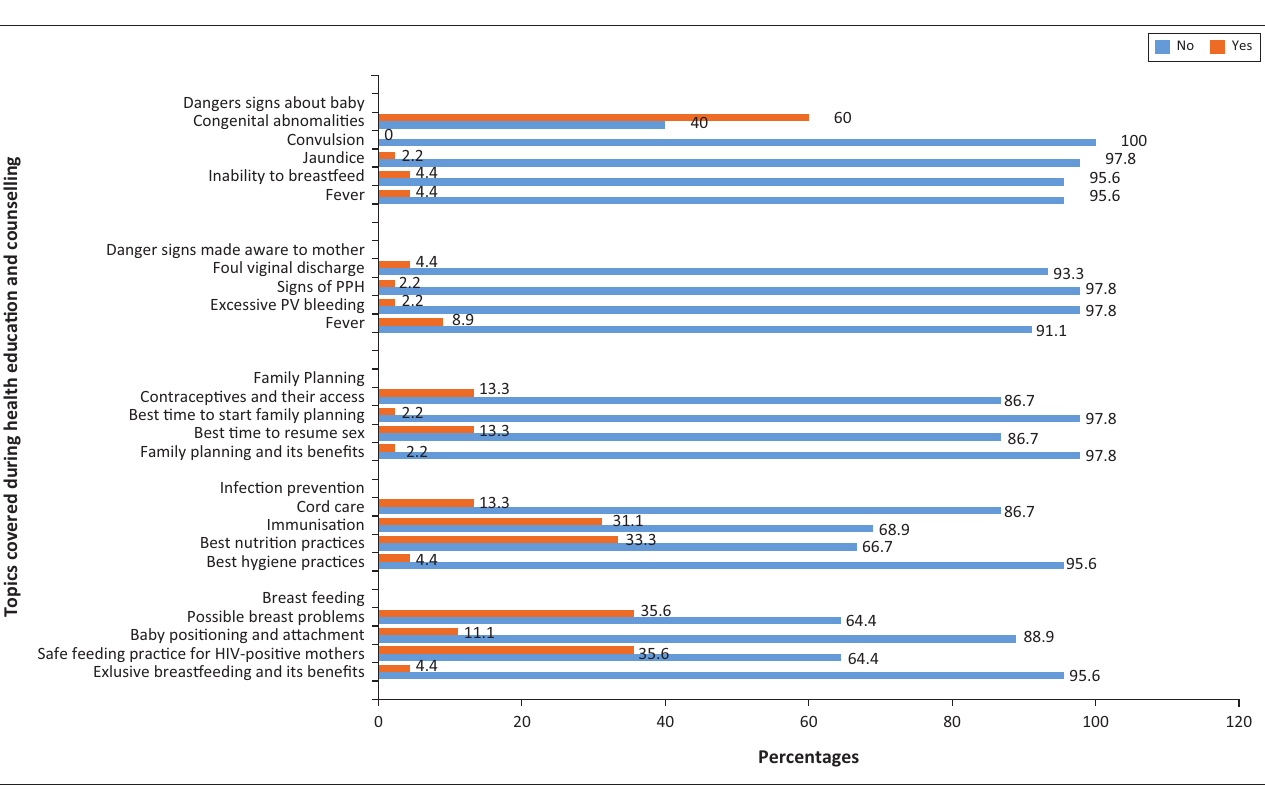
FIGURE 3: Health education and counselling topics covered by midwives during postnatal